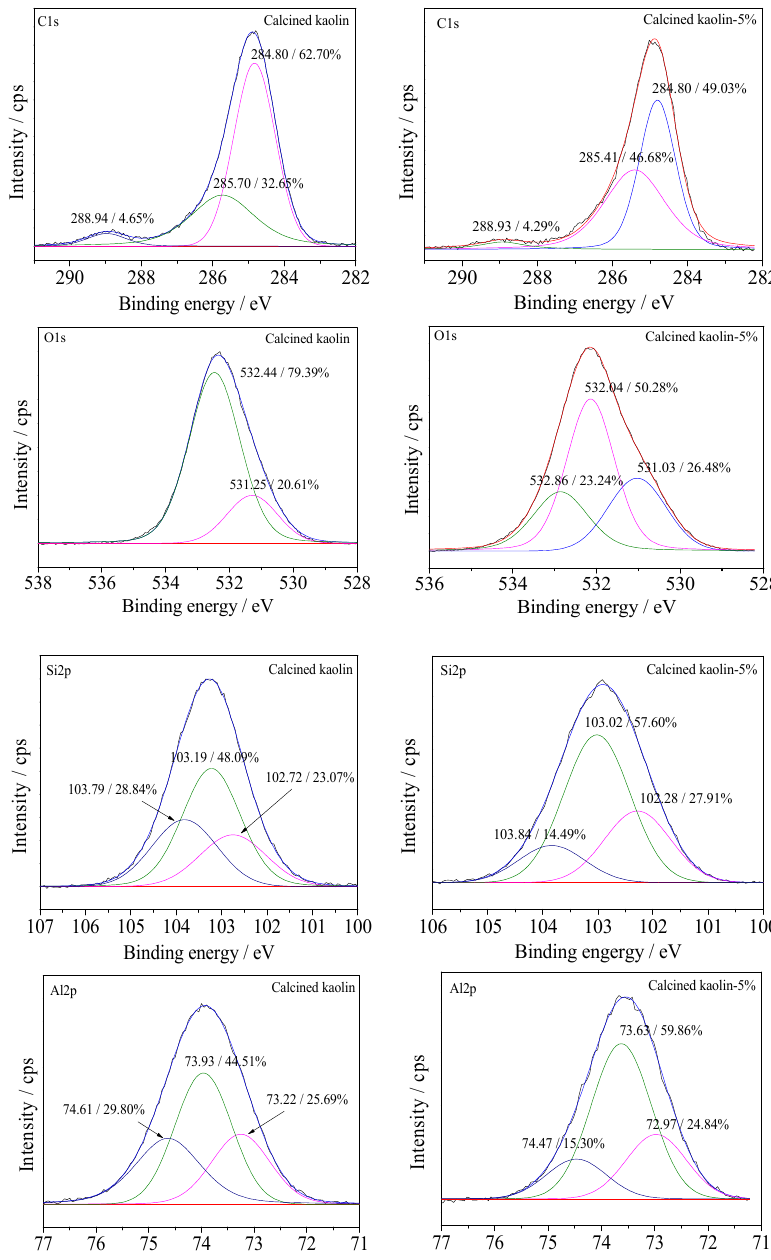
Figure 6. The broad scan XPS spectra of calcined kaolin and calcined kaolin-5%. Figure 7 shows the fitting peaks of XPS spectra of C1s, O1s, Si2p, and Al2p for the calcined kaolin and calcined kaolin-5% by PeakFit software. The fitting results are shown in Figure 7. In the Cls spectra of calcined kaolin, according to the XPS standard electronic binding energy table, three peaks at 284.80, 285.70, and 288.94 eV are assigned to C-H [30], C-OR bonds, and COOR groups, respectively. After surface modification, they moved to 284.80, 285.41, and 288.93 eV, respectively. The percentage of C-H bonds decreased to 49.03% from 62.70%. The C-OR groups increased from 32.65% to 46.68%, whereas the COOR groups only slightly decreased from 4.65% to 4.29%, indicating that the APTES existed on the surface of calcined kaolin, and the OC 2 H 5 groups were towards the outside. Therefore, their relative percentage changes as described above.